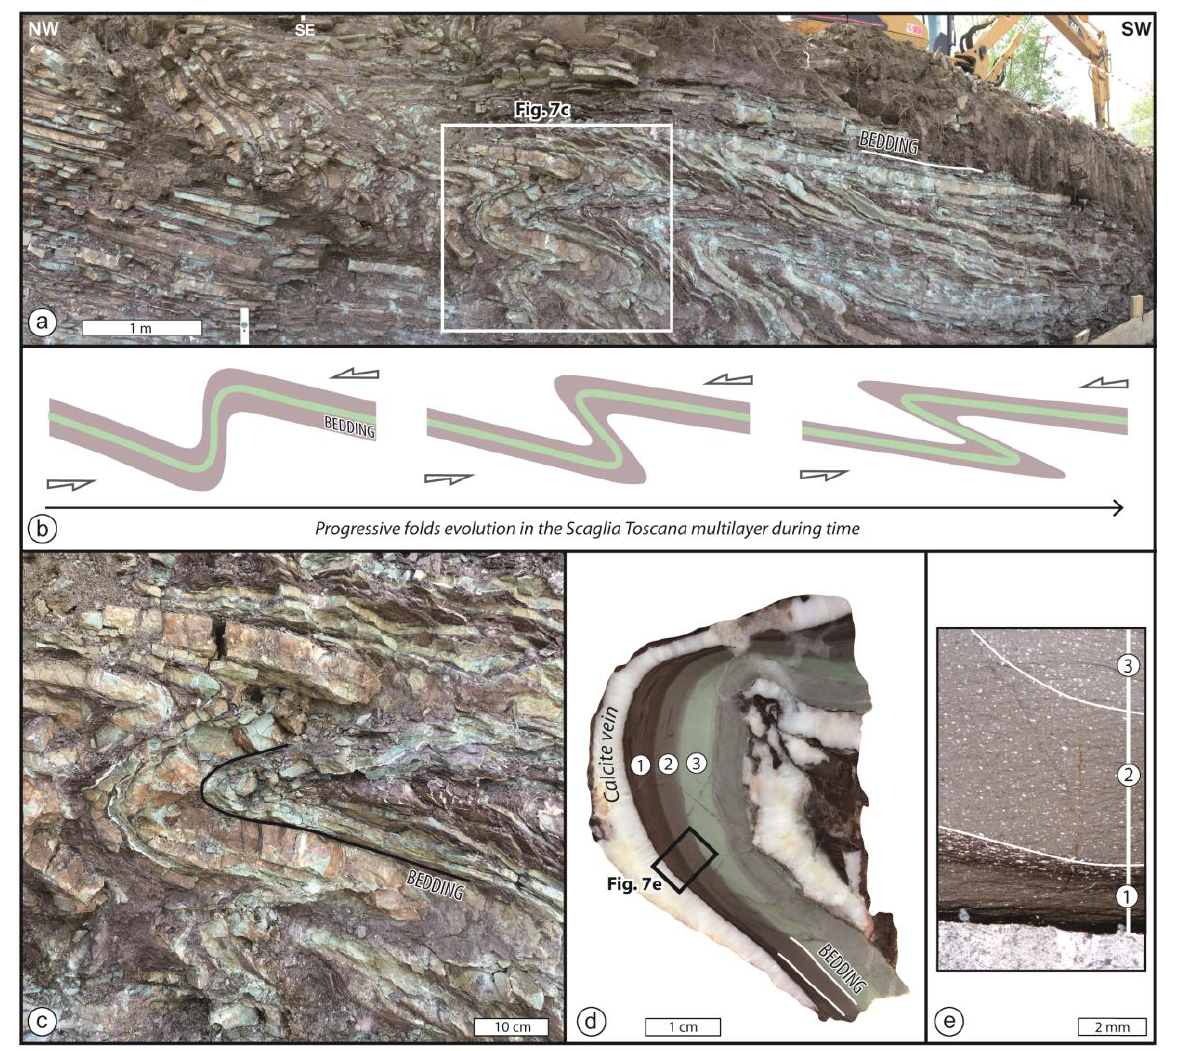
Figure 7. The folds of Bosa geosite. ( a ) General view of the outcrop during the excavations for the foundations of the cellar of the Apuan Alps UGGp farm in Bosa (Careggine, Lucca); ( b ) Sketch showing evolution of the folds shown in ( a ). The bedding, originally horizontal, was folded due to a progressive shearing shown by white arrows; ( c ) Detail of fold at the outcrop scale; ( d ) Hand sample fold used for the thin section. The bedding is highlighted by different colors that reflect different rocks composition. Numbers 1, 2 and 3 indicate three different compositional layers: 1—clay-rich layer; 2—clay-carbonate mixed layer; 3—carbonate layer. The location of ( e ) is also shown; ( e ) Photomicrograph (plane polarized light) from the thin section obtained from the sample in ( d ). Numbers 1, 2, and 3 indicate the same compositional layers shown in ( d